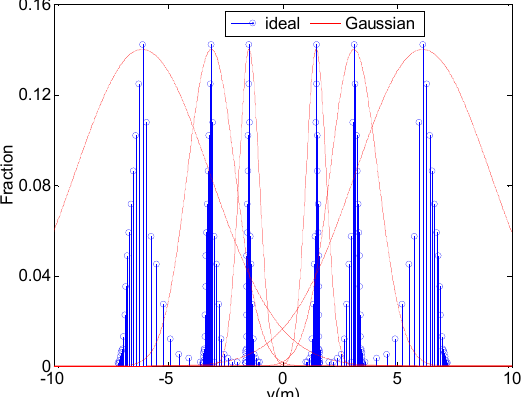
Figure 11. Path lines of flow field in NGE phase as approximations to trajectories of 10 μ m droplets.